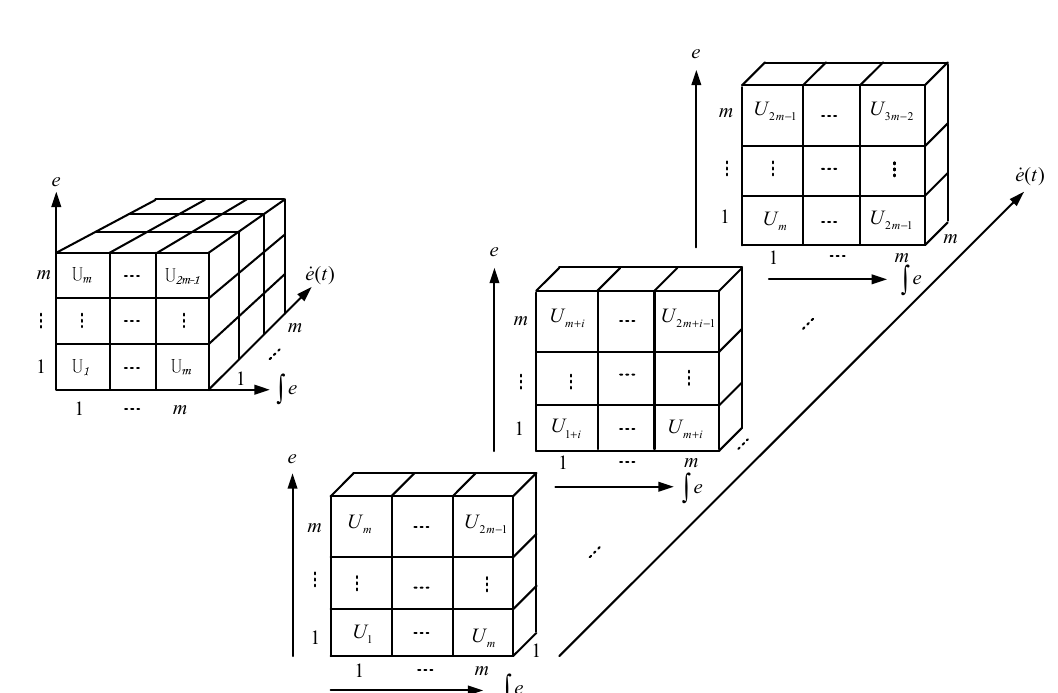
Figure 2. Sliced cube fuzzy associative memory (FAM) representation of the knowledge base.